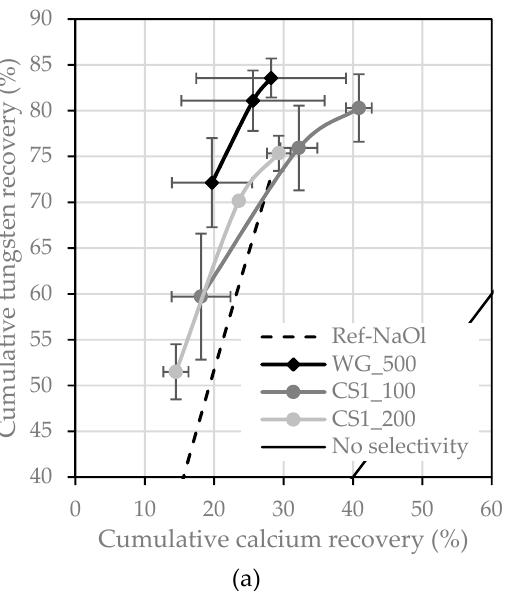
Figure 7. Selectivity curves of tungsten against ( a ) calcium (calcium contained in scheelite was subtracted) and ( b ) silica (error bars represent the 95% confidence interval).